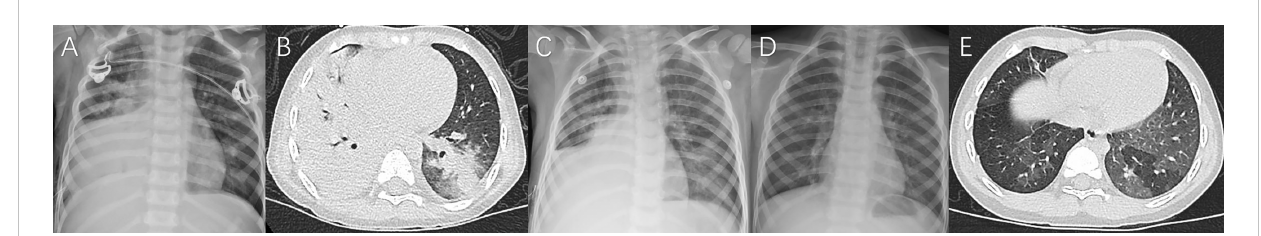
FIGURE 6 Case 6. Chest imaging showed bilateral/unilateral high-density lesions (A, day 9; B, day 10; C, day 11), right pleural effusion (A – C) , no abnormality ( D , day 24), and the signs of bronchiolitis obliterans-associated mosaic perfusion ( E , 9 months after illness